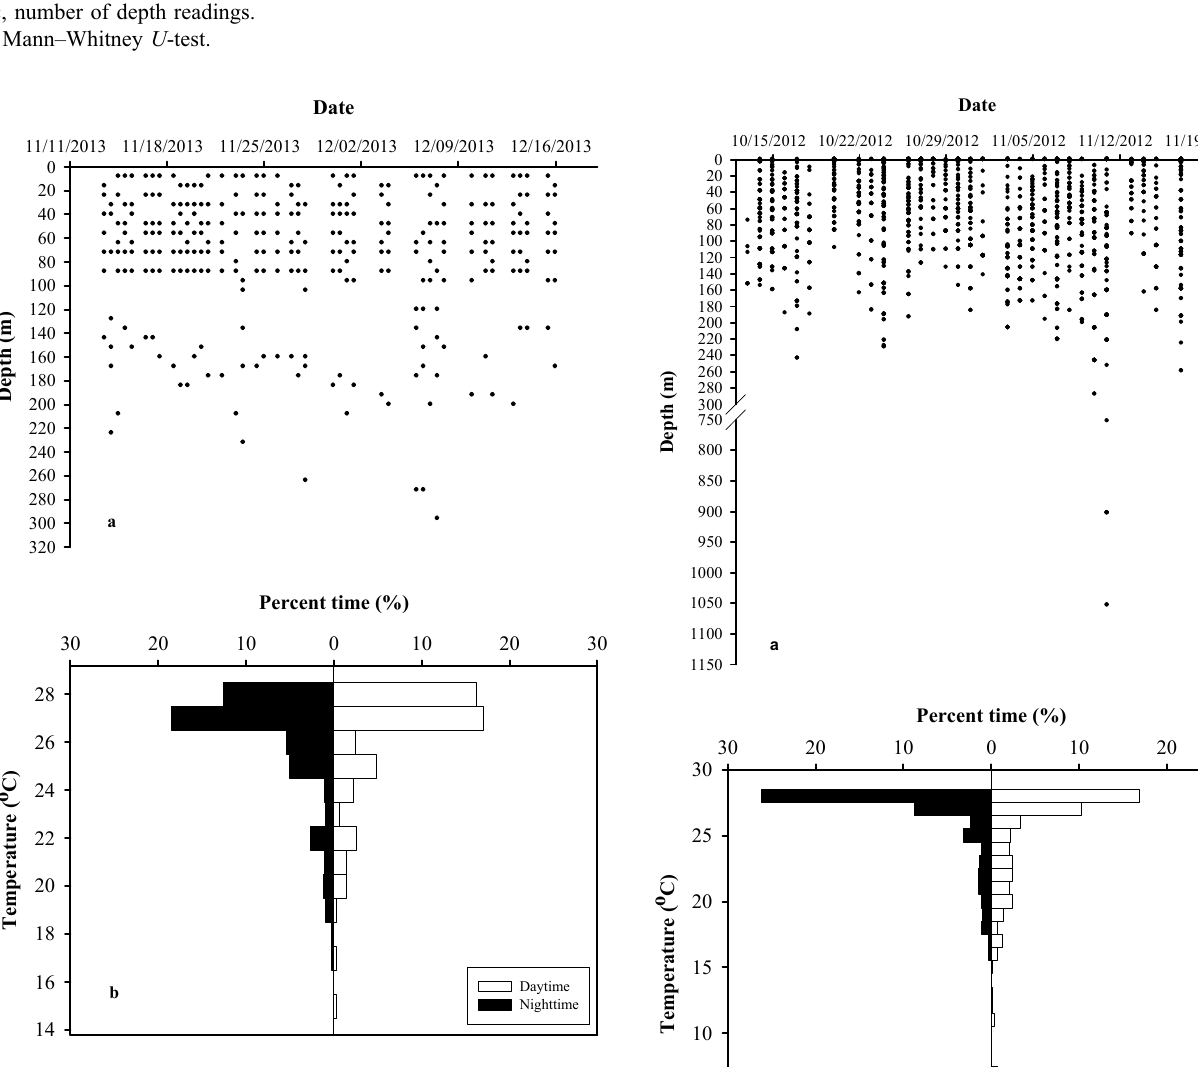
Fig. 7. Vertical movement distribution (a), and percentage of time spent at different temperature (b) for the fi sh bearing tag F.